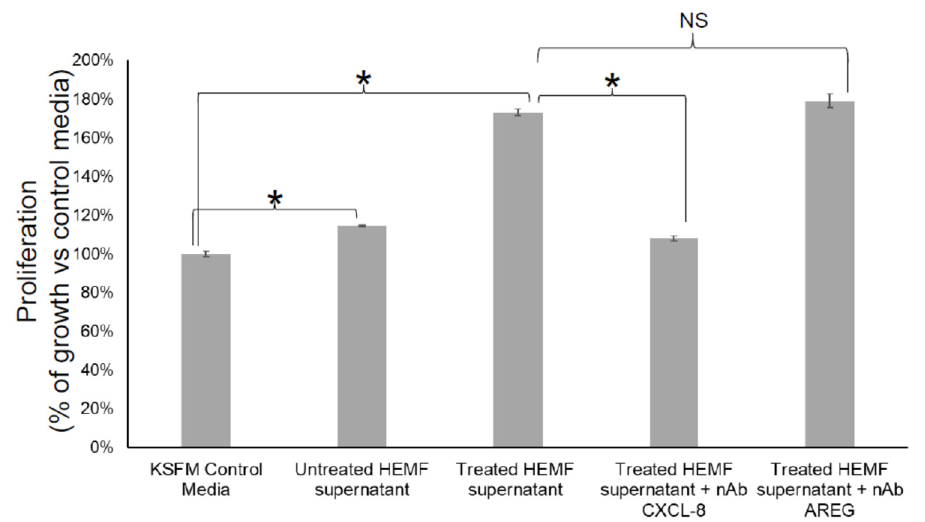
Figure 11. Epithelial cell proliferation in response to inhibition of HEMF-derived factors. Epithelial cells (2000 cells/well of 96-well plate) were treated with KSFM (epithelial cell media) or supernatant of untreated and acidic-bile-salt-treated HEMFs (in background KSFM media overnight) in the presence and absence of neutralizing antibodies for CXCL-8 and AREG. Results shown represent the means ± SEM of three independent experiments conducted with a HEMF cell line * p < 0.05; NS, nonsignificant with ANOVA with multiple comparisons.